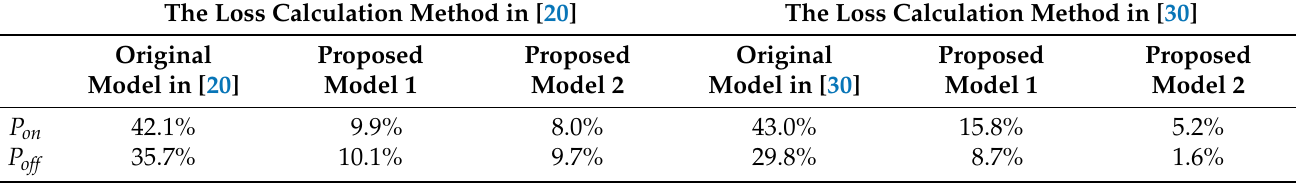
Table 5. The average relative error of different loss models based on two calculation methods when the load current I L changes from 4.0 A to 14 A at 10 MHz, 10 V input voltage, and 5 V gate driving